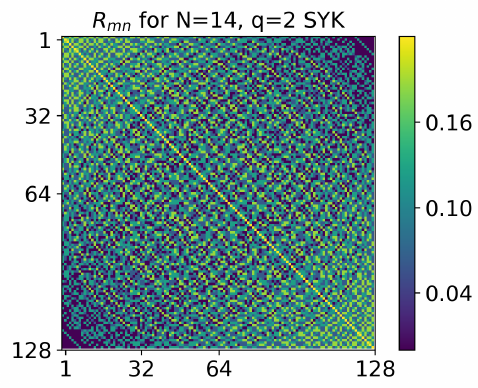
Figure 14 . Level spacing for the (a) q = 2 and (b) q = 3 , 4 SYK models, with exponential and Wigner-Dyson level spacing distributions, respectively.